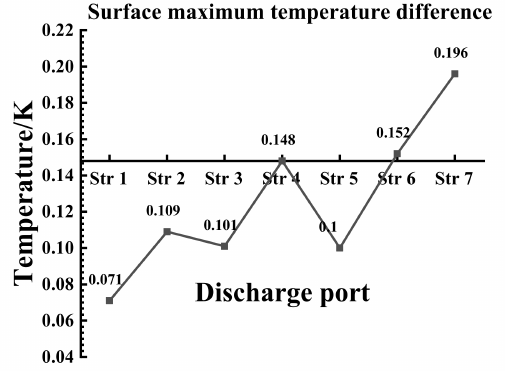
Figure 9. Surface maximum temperature difference of the thermal jet for different radius ratios of oval discharge